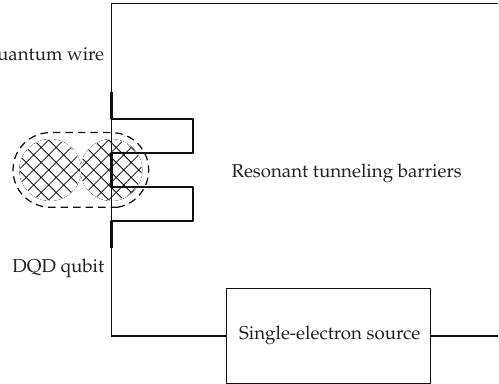
Figure 2: A schematic diagram of the system for generating entanglement between a ballistic electron and double quantum dot (cid:9) DQD (cid:10) single-electron charge qubit. The ballistic electron is pumped through the resonant tunneling barriers in the quantum wire by a single-electron source. Resonant tunneling occurs when the qubit electron is localized to the dot furthest from the wire, the | 0 (cid:2) state, and is suppressed by Coulombic interaction when the qubit electron is localized to the dot closest to the wire, the | 1 (cid:2)